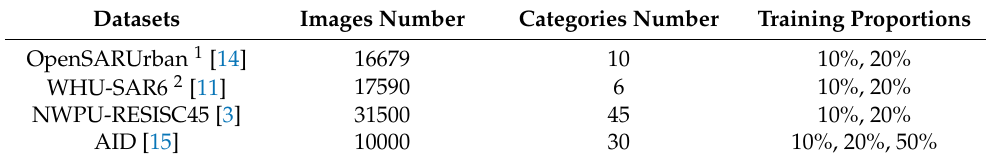
Table 1. Datasets description and training proportions.